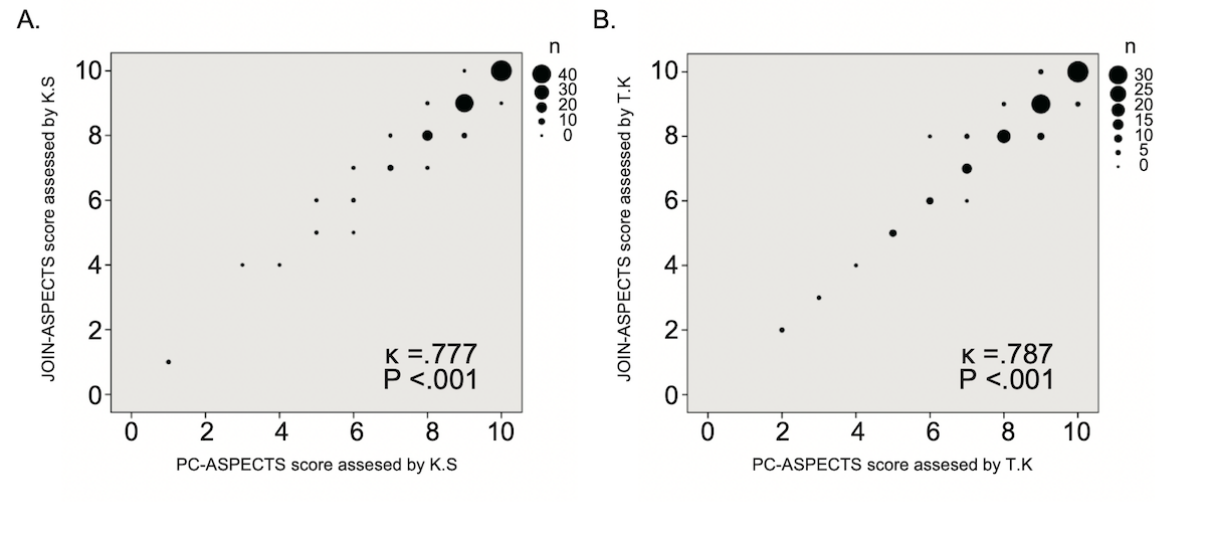
Figure 3. Scatter diagram of the DWI-ASPECTS results of vascular neurologists KS (A) and TK (B) between JOIN-ASPECTS and PC-ASPECTS for all patients. DWI-ASPECTS: Diffusion-Weighted Imaging–Alberta Stroke Program Early Computed Tomography